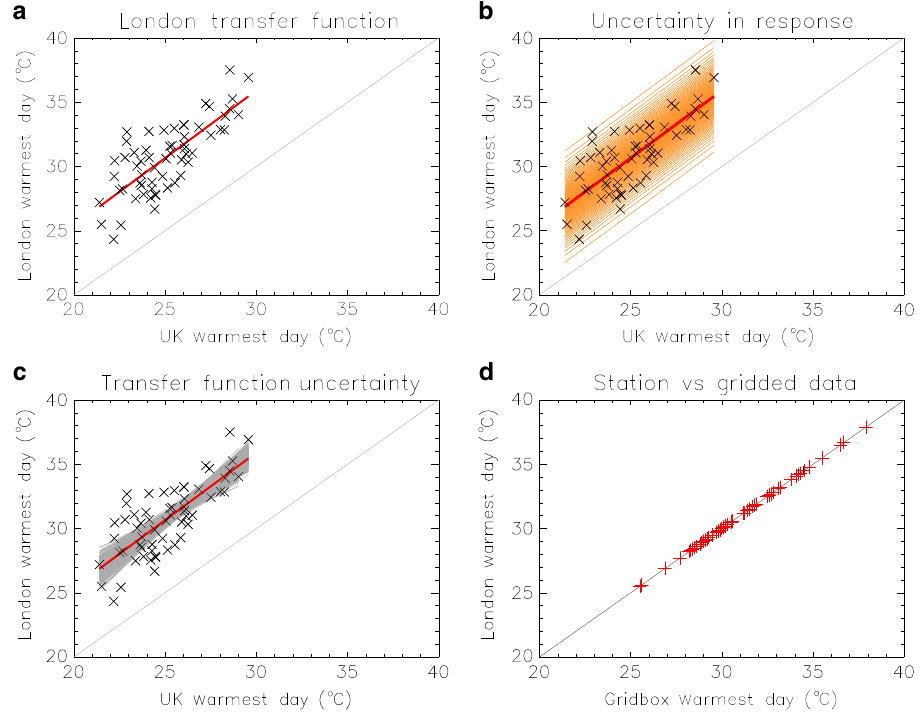
Fig. 2 Transfer functions for the estimation of the local warmest daytime temperature ( tx01 ). An example for a grid-box in London. a Local observations of tx01 plotted against the UK mean observed values (crosses). A linear fi t to the data (red line) represents the transfer function for the grid-box. b Inclusion of the con fi dence bounds for the response variable (orange lines) leads to a set of a 100 transfer functions in total. c A bootstrapping procedure applied to the observed data (crosses) provides alternative transfer functions (grey lines), used to assess the effect of sampling uncertainty. For each of the grey lines, a set of 100 transfer functions can be obtained as shown in panel b . d Observed tx01 data from a station within the reference grid-box agree well with the HadUK-Grid